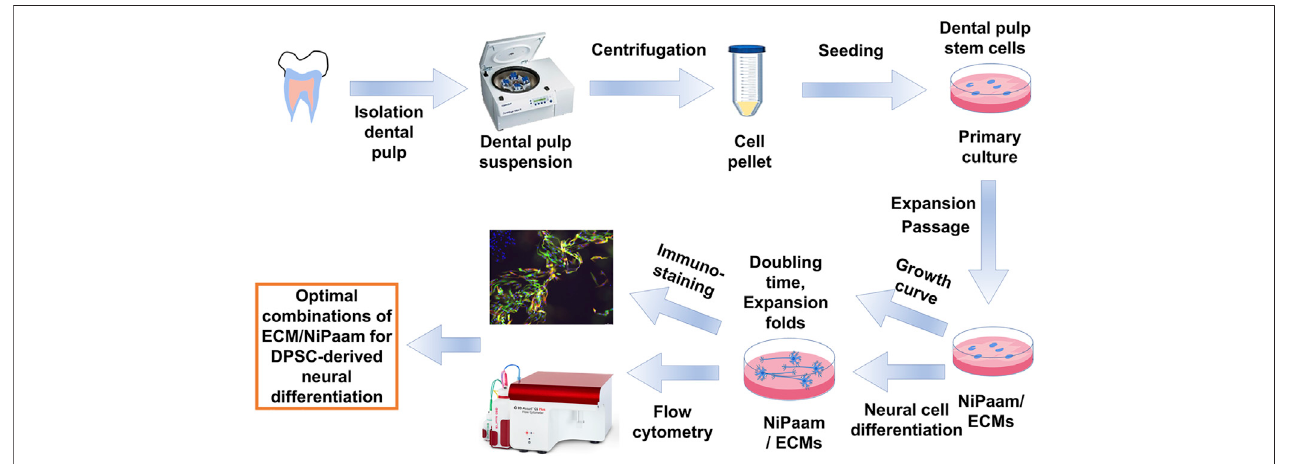
FIGURE 1 | Experimental scheme of DPSCs extraction, culture, characterization and differentiation into neuronal cells.